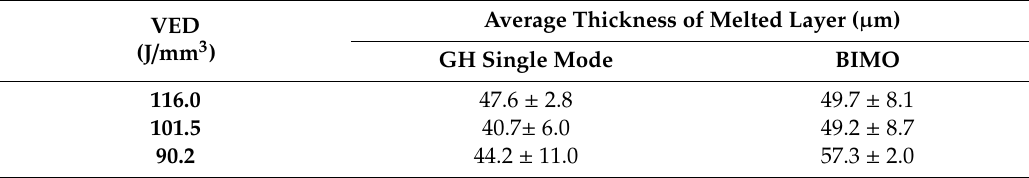
Table 4. Average thickness of melted layer for GH single-mode and BIMO powder at VED of 90.2, 101.5 and 116 J / mm 3